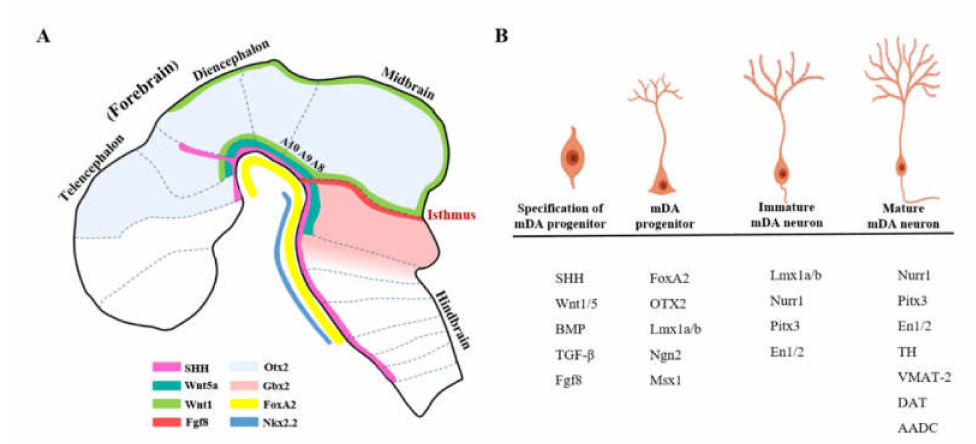
Figure 3. Signaling and morphogens involved in midbrain and mDA neuron development: ( A ) Sagittal plane of the brain, which illustrates the expression of the morphogens and transcription factors located in the midbrain and hindbrain, and ( B ) the main transcription factors expressed in the di ff erent stages of mDA progenitor or mDA neuron. (Adapted from Reference